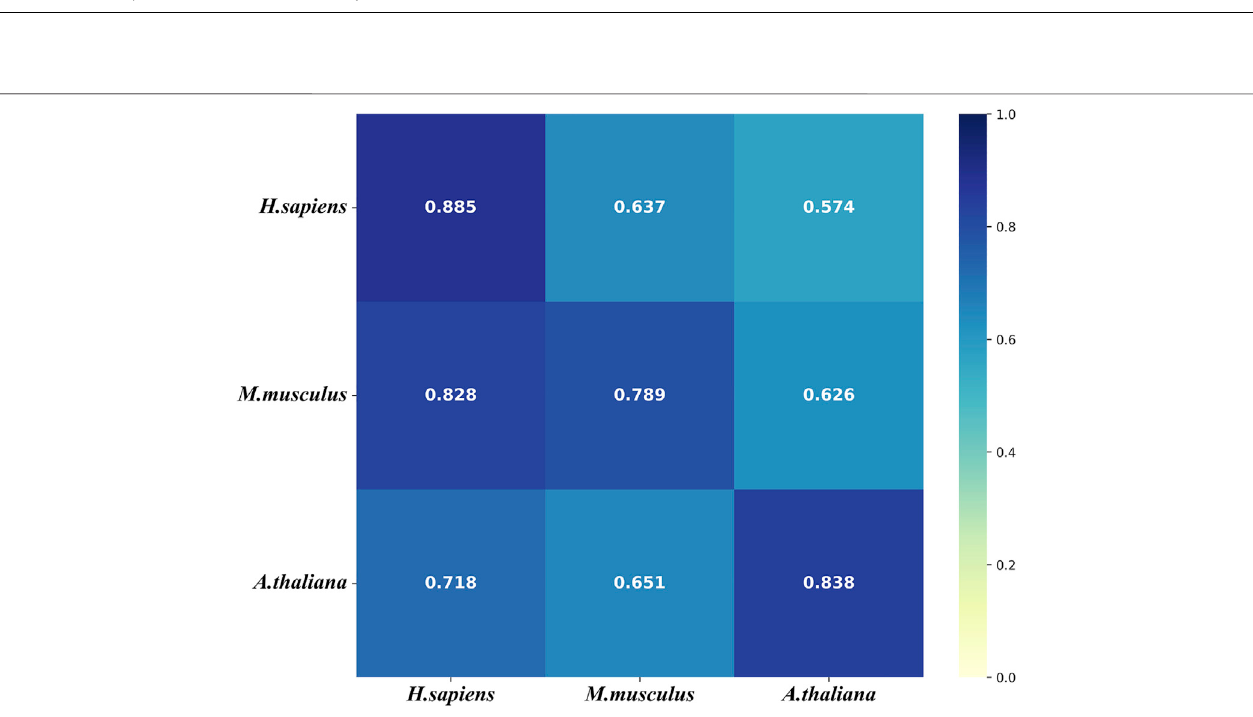
FIGURE 7 | The heat map for the cross species predictive AUROCs. The models ( y -axis) were tested on the three independent test sets ( x -axis).